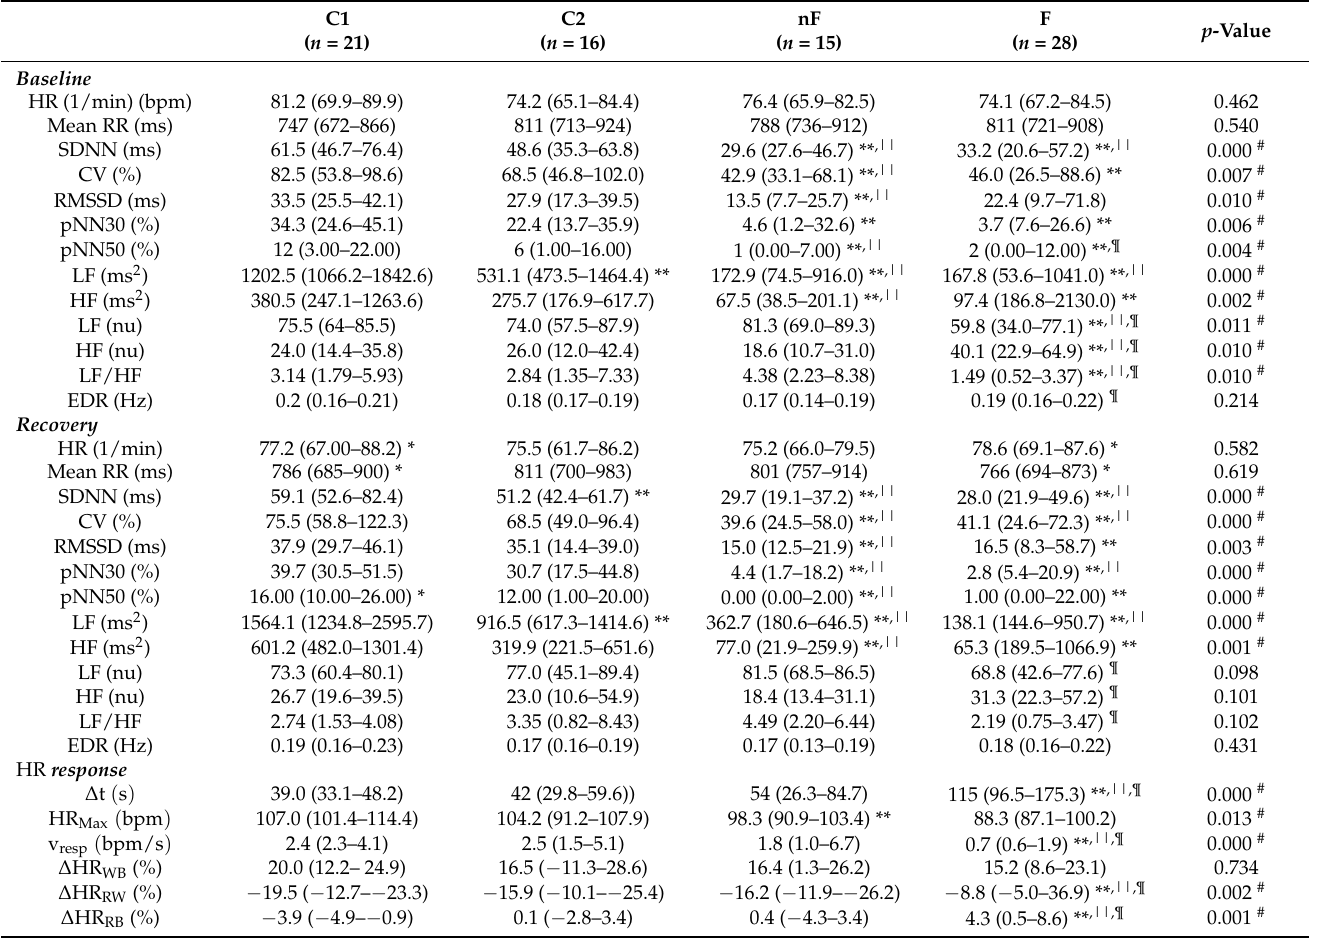
Table 2. Heart rate response ∆ HR and linear HRV parameters evaluated from a 160-m walking test in young adults (C1), middle-aged adults (C2), non-frail older adults (nF), and frail older adults. C1 ( n = 21)